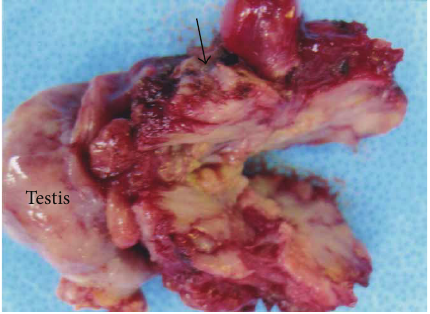
Figure 3: Gross appearance of the resected tumor. Gross exami- nation shows grayish-white mass (arrrow) in the cut surface of the resected